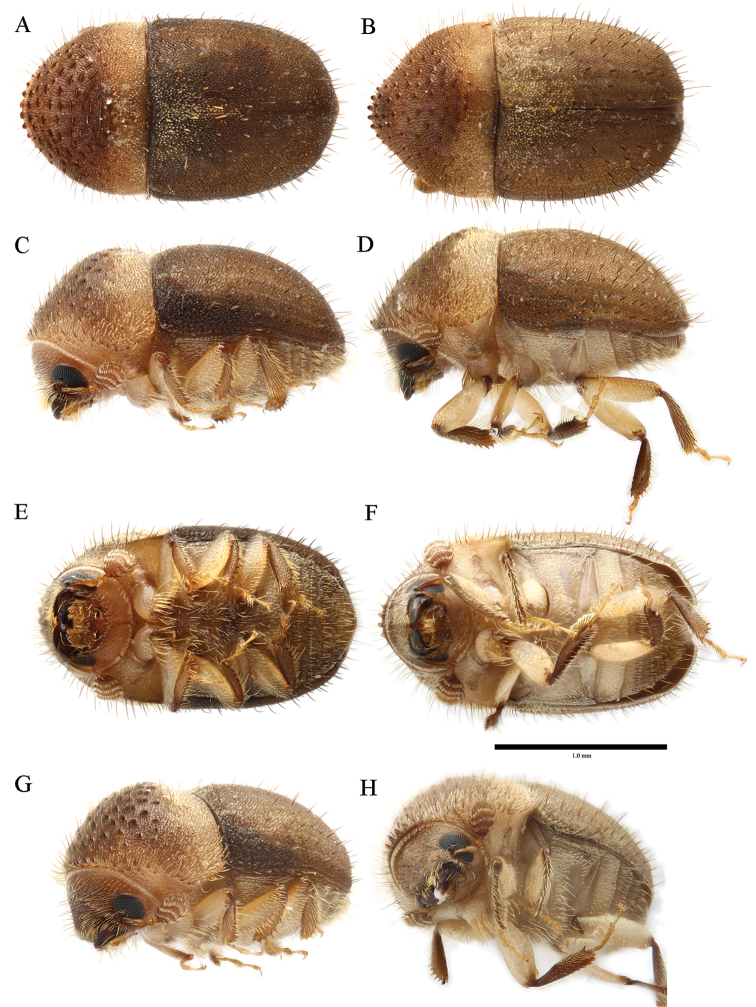
Cryphalus
dorsalisA, C, E, G female, UFFE:34070 B, D, F, H male, UFFE:21476.